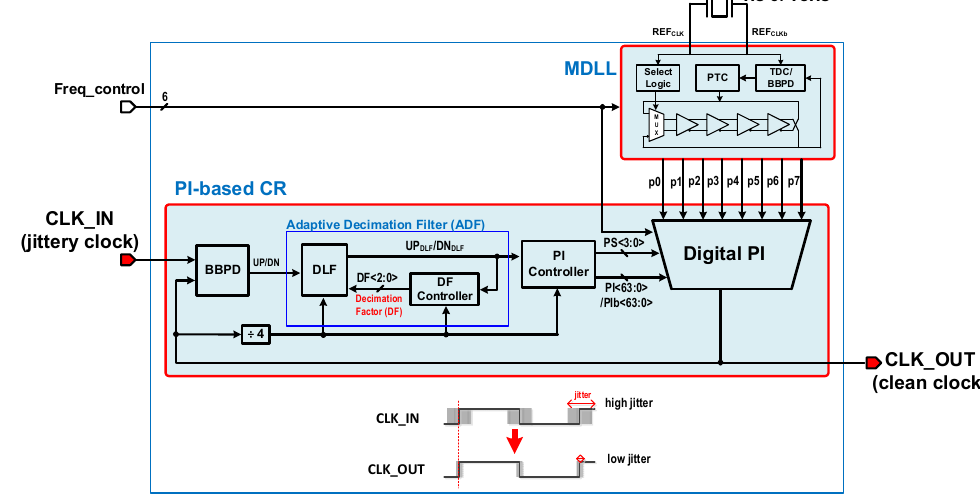
Figure 3. Proposed all-digital dual-loop jitter attenuator (DJA) architecture.